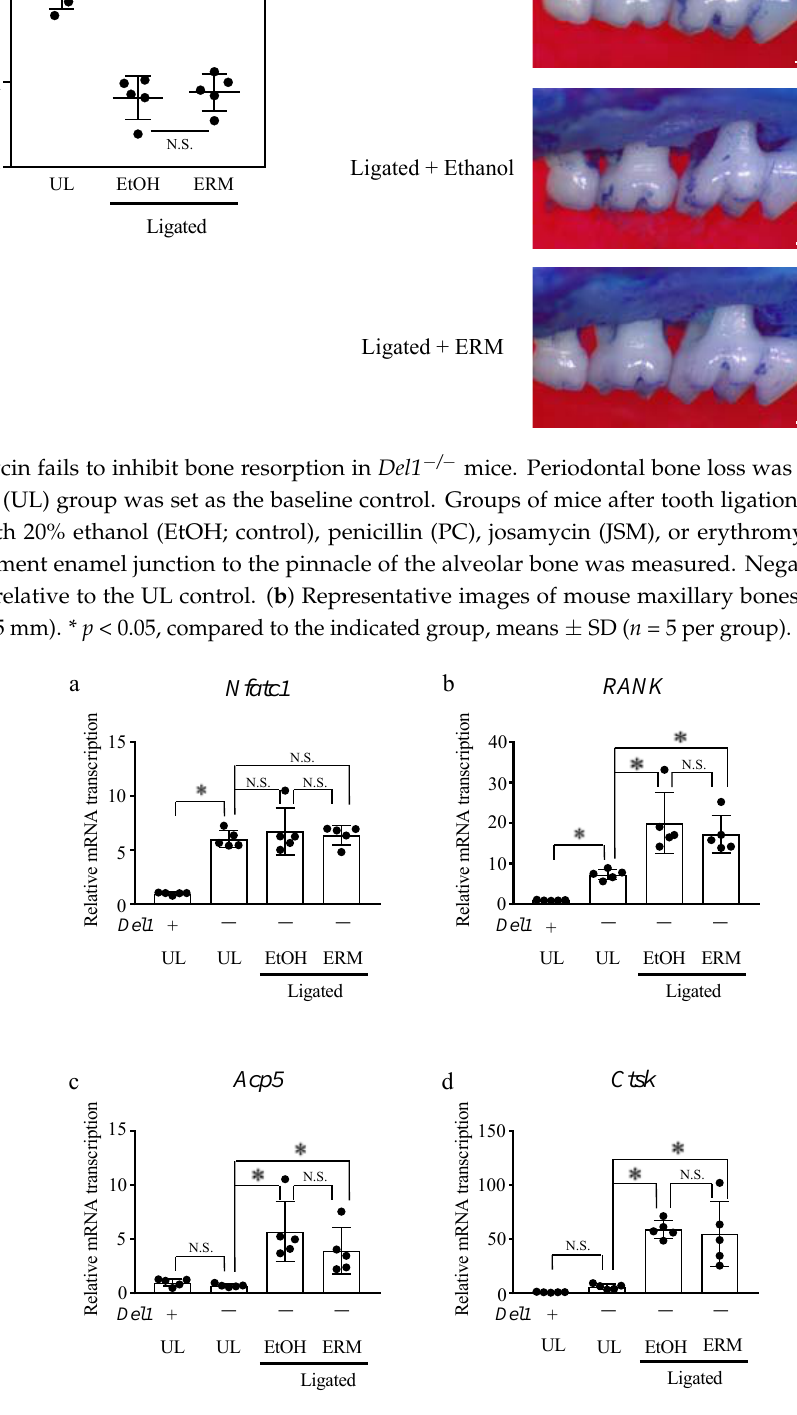
Figure 5. Effect of erythromycin on the transcription of osteoclast-related factors in Del1 -/- mice. ( a – d ) Real-time qPCR was performed to quantify the mRNA transcription levels of osteoclast-related factors in Del1 -/- mice. * p < 0.05 compared to the indicated groups, means ± SD ( n = 5 per group). N.S., not significant.